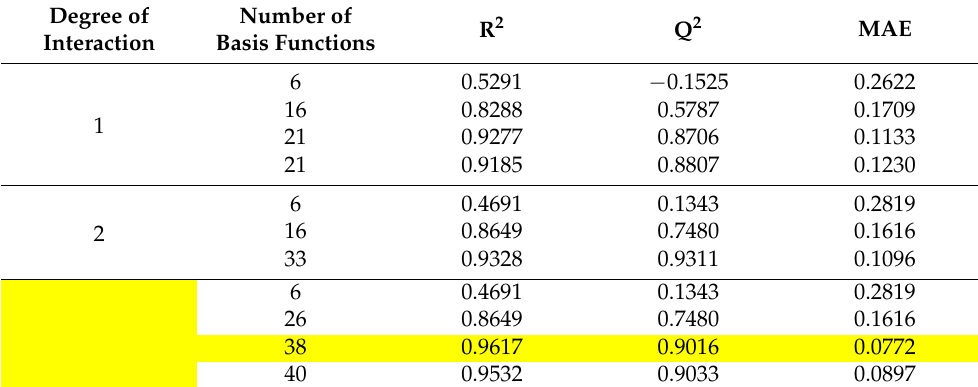
Table 4. Values of validation parameters of models obtained with the MARSplines procedure (the optimal model marked in